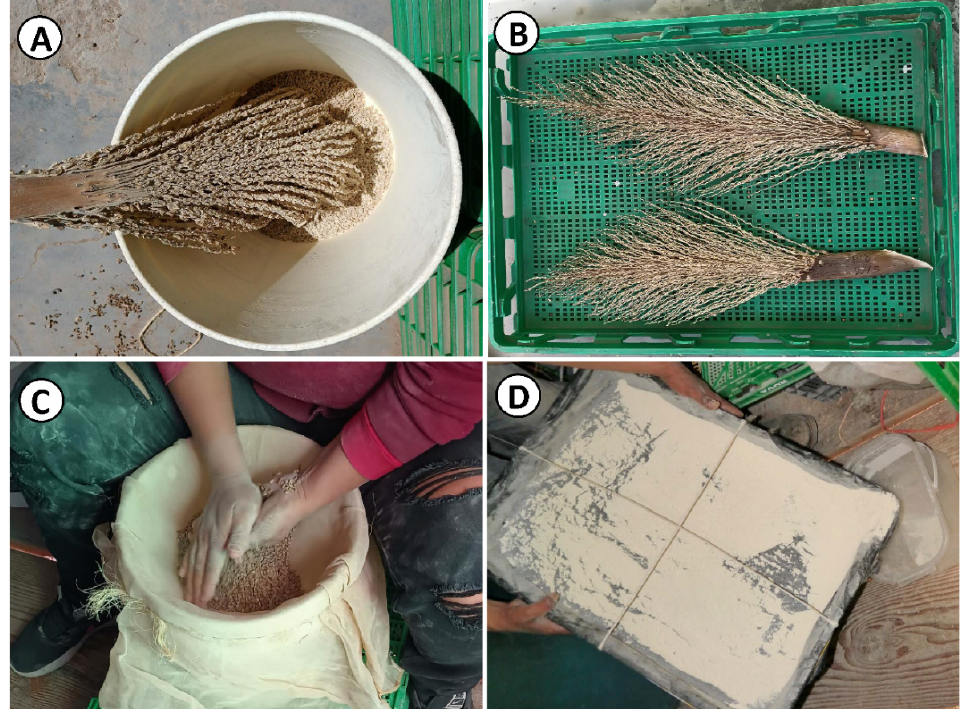
Figure 3. Date palm pollen extraction process. ( A ) Shaking the inflorescence in a plastic container. ( B ) Leaving only dry strands after all their flowers were manually removed. ( C ) Manual process of pollen extraction and filtering. ( D ) Final collection of filtered fresh pollen, ready to use.